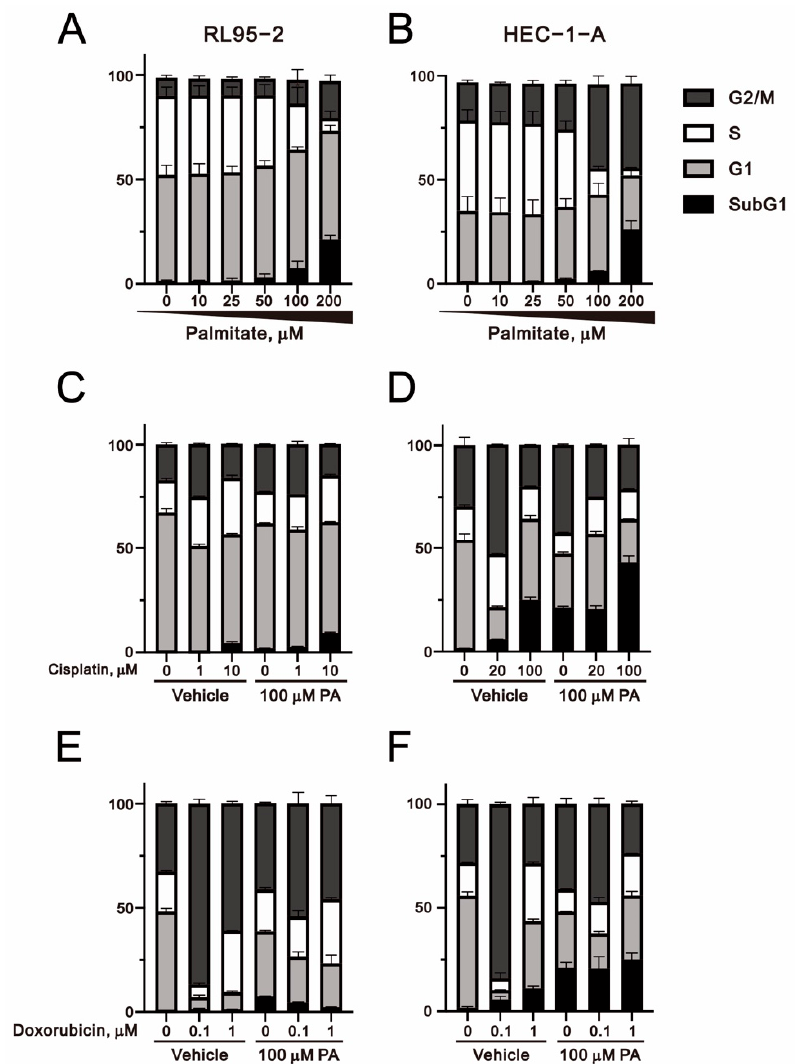
Figure 4. Effect of palmitate alone and in combination with cisplatin or doxorubicin on the cell cycle profiles in human endometrial cancer cells. ( A , C , E ) RL95-2 and ( B , D , F ) HEC-1-A cells were incubated for 24 h, after which they were treated with the indicated concentrations of doxorubicin or cisplatin plus 100 µ M palmitate for 24 or 48 h. Cell cycle profiles were then analyzed using flow cytometry. Bars depict the mean ± SD of three independent experiments.